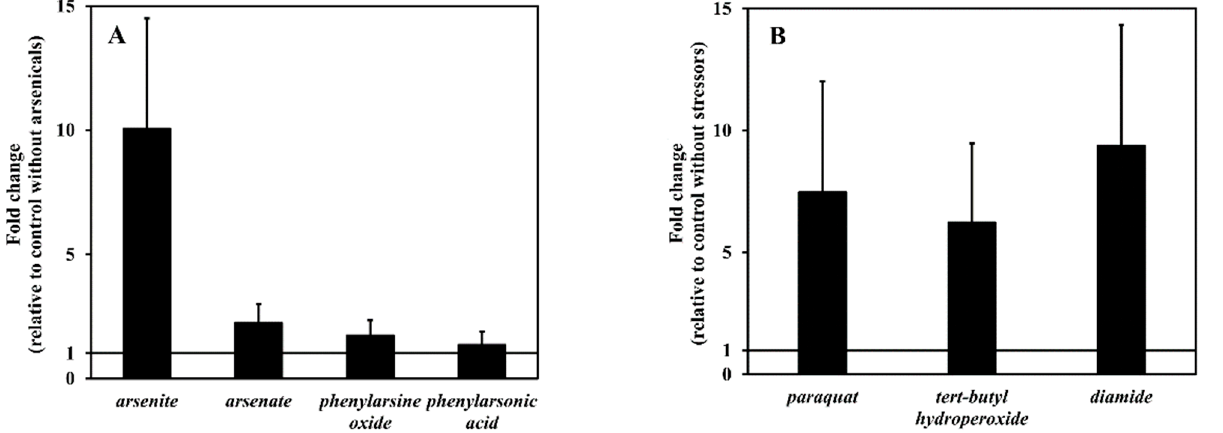
Figure 5. Transcriptional level analysis of the arsH gene. Panel ( A ), the effect of various arsenicals and phenylarsenicals; panel ( B ), the effect of various oxidative stressors. Bars represent the mean ± SD for three measurements. Relative mRNA level of the arsH gene were normalized to three house-keeping genes and quantified relative to the wild-type strain without any effectors.